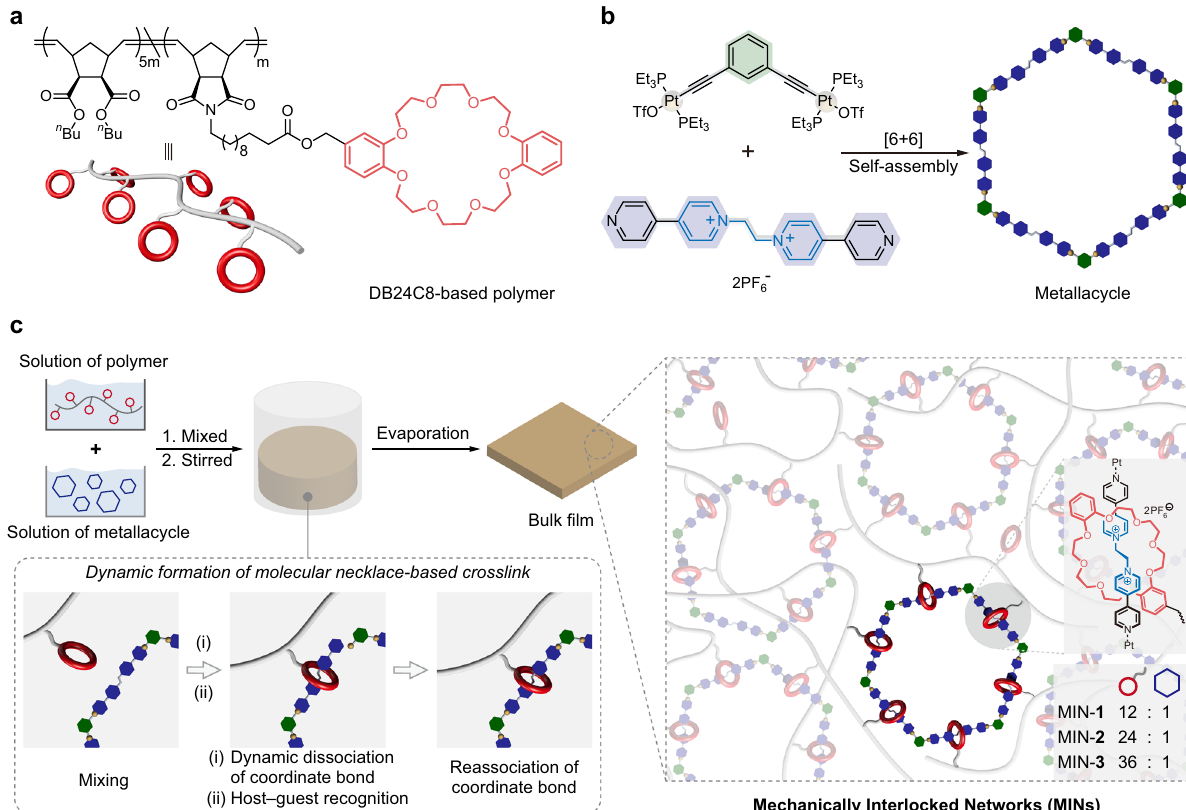
Fig. 2 Preparation of the MINs. a Chemical structure and corresponding cartoon of DB24C8-based polymer. b Schematic representation of the formation of the metallacycle via coordination-driven self-assembly. c Schematic representation of the preparation of the molecular necklace cross-linked MINs via dynamic host − guest recognition between DB24C8 moieties and